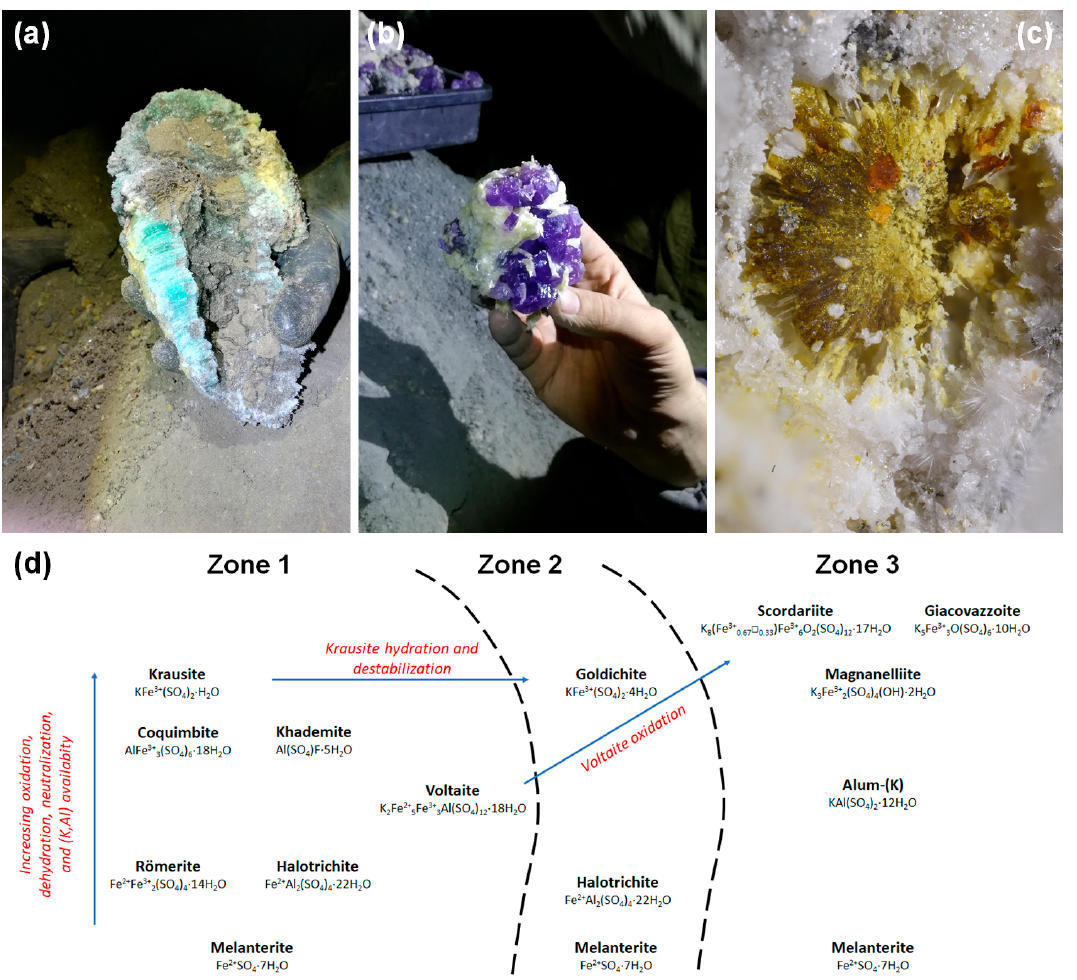
Figure 30. Melanterite is the first oxidation product of pyrite in the Monte Arsiccio mine ( a ). In the sulfate sequence, it is followed by several species, showing increasing oxidation and the addition of other elements (e.g., K, Al). Several of these species (voltaite, coquimbite, krausite) are included in halotrichite, as exemplified by the purple crystals of coquimbite embedded in fibrous white halotrichite ( b ). Krausite, in the outer portion of the sulfate assemblage, tends to hydrate and to be destabilized, being replaced by other phases. In ( c ), a radial aggregate of krausite, 5 mm in diameter, is almost fully replaced by magnanelliite, scordariite, and giacovazzoite, and it is embedded in alum-(K). In ( d ), the most characteristic species identified in the Monte Arsiccio sulfate assemblage are reported, according to their occurrence in different zones, from the core of the pyrite ore body (Zone 1) towards the surface (Zone 3), passing through the intermediate Zone 2.